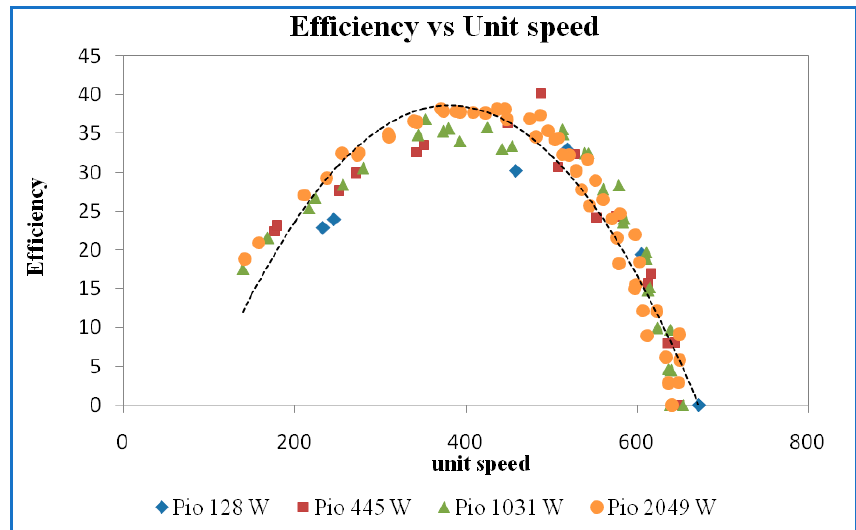
Figure 27. Efficiency vs. unit speed at a guide vane opening of 10 mm. For a guide vane opening of 13 mm, the unit discharge versus unit speed curve is shown in Figure 28. The unit discharge decreases with increase in unit speed at this guide vane opening also. When compared to that for 10 mm, the unit discharge increases and decreases with increasing speed.